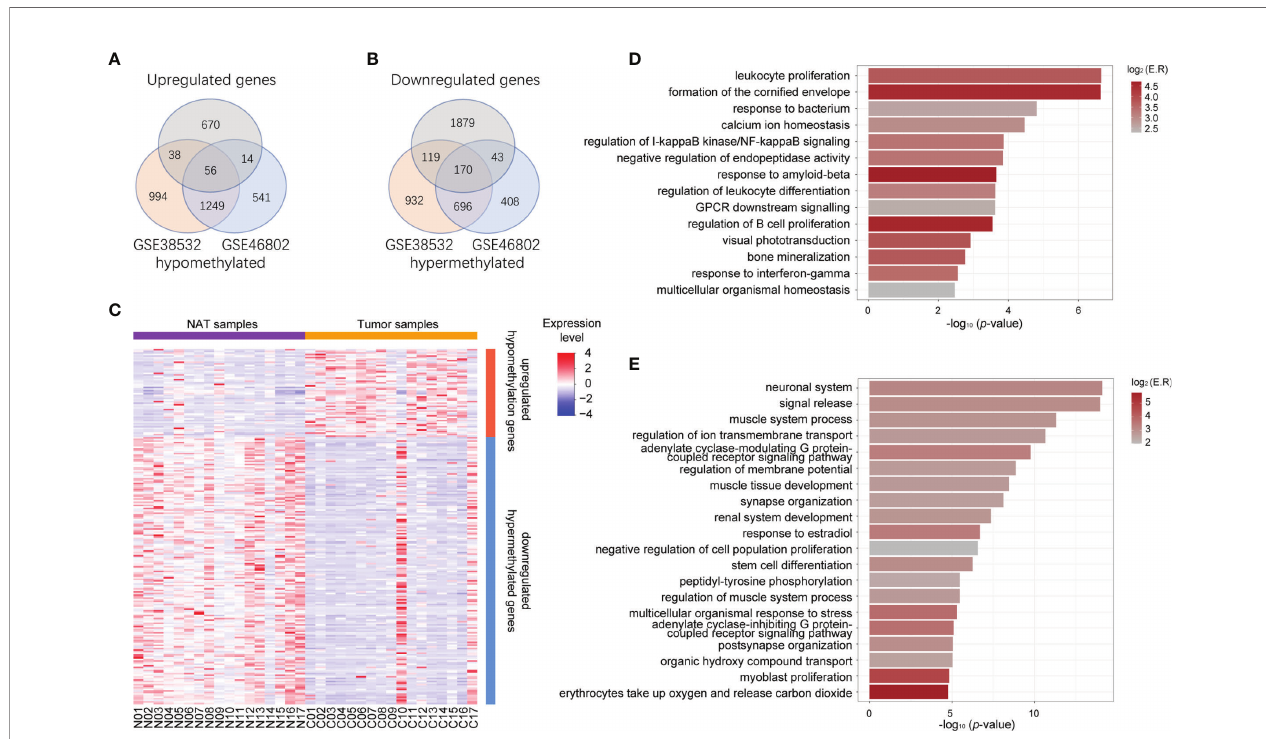
FIGURE 2 | Identi fi cation of aberrantly methylated and differentially expressed genes. (A) Venn diagram of upregulated genes (grey circle) and hypomethylated genes common to both methylation datasets (orange circle for dataset GSE38532 and blue circle for dataset GSE46802). (B) Venn diagram of downregulated genes (grey circle) and hypermethylated genes common to both methylation datasets (orange circle for dataset GSE38532 and blue circle for dataset GSE46802). (C) Heatmap representing expression level of all the NAT and tumor samples (columns) and genes (rows) detected as methylation-regulated differentially expressed. (D) Bar plot represents functional clusters of upregulated-hypomethylated genes with statistical signi fi cance. X-axis indicates -log 10 ( p -value), color indicates log 2 (enrichment ratio). (E) Bar plot represents functional clusters of downregulated-hypermethylated genes with statistical signi fi cance. X-axis indicates -log 10 ( p -value), color indicates log 2 (enrichment